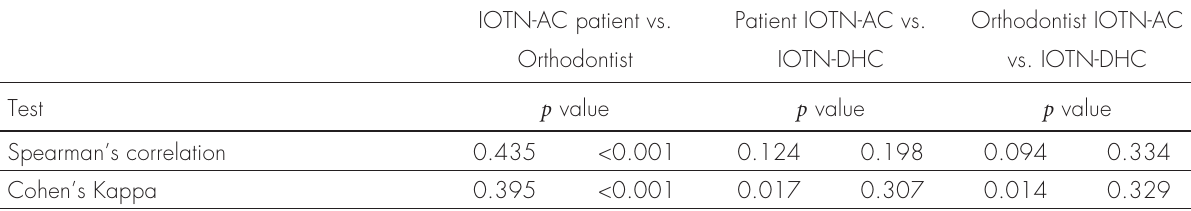
Table III. Agreement and correlation between patient and orthodontist IOTN AC scores and normative need.